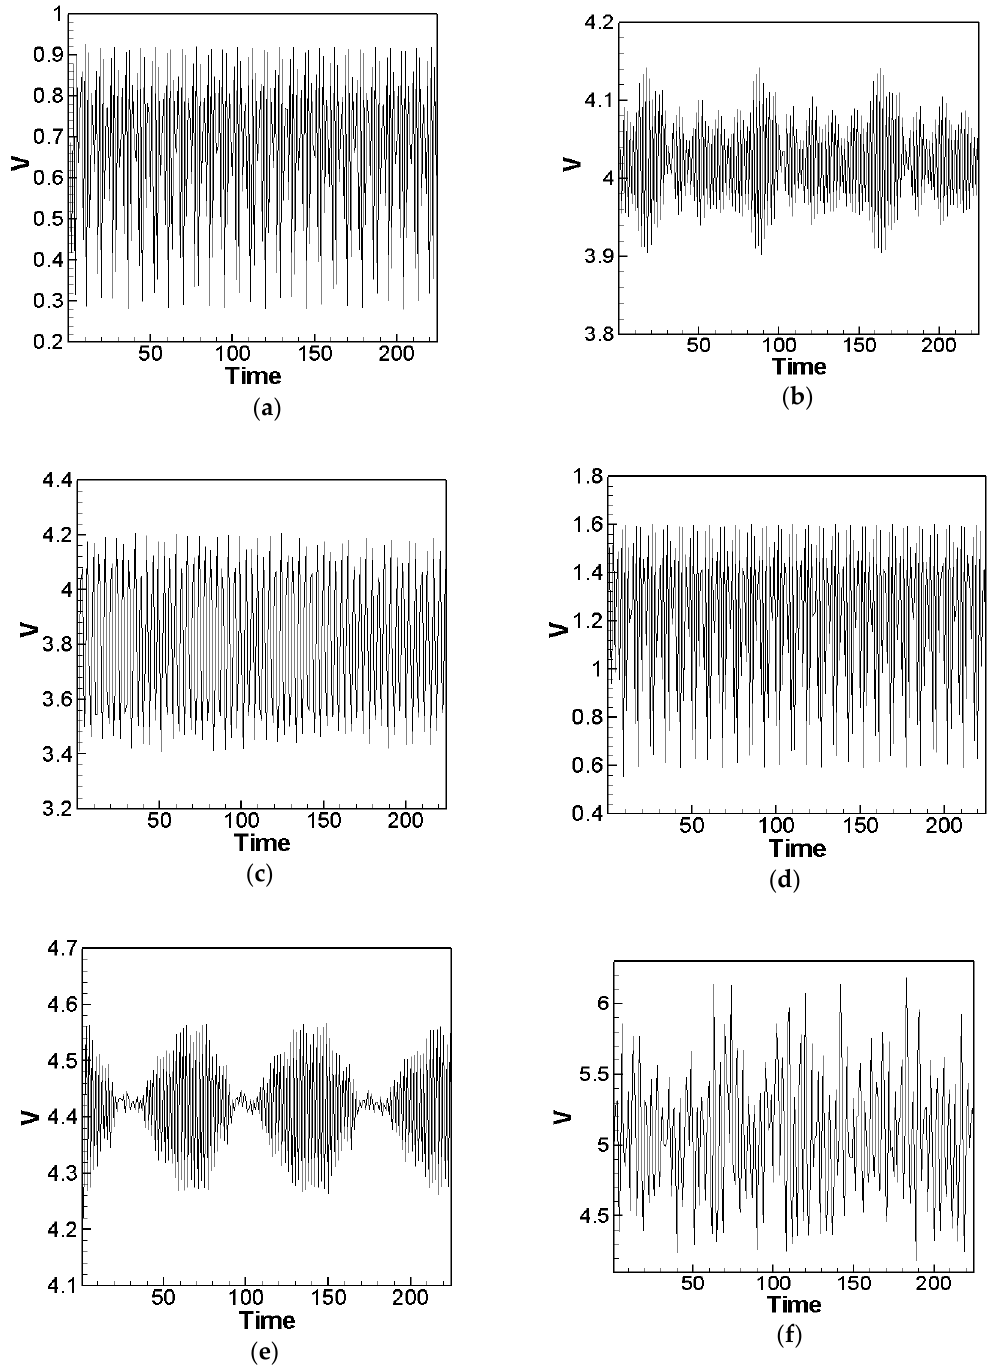
Figure 16. numerical simulation of AC voltage—RMS (moving average).( a ) SESS 1st mode, ( b ) SESS Figure 16. Numerical simulation of AC voltage—RMS (moving average). ( a ) SESS 1st mode, ( b ) SESS 2nd mode, ( c ) SESS 3rd mode,( d ) DESS 1st mode, ( e ) DESS 2nd mode, ( f ) DESS 3rd mode. 2nd mode, ( c ) SESS 3rd mode, ( d ) DESS 1st mode, ( e ) DESS 2nd mode, ( f ) DESS 3rd